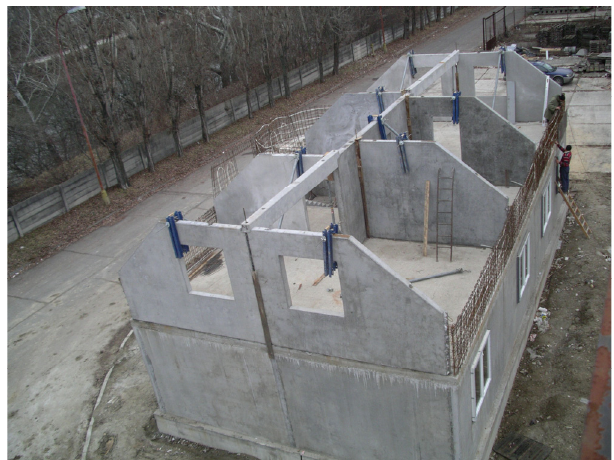
Figure 9. View of the assembly of the prototype prefabricated house IDA I. (Photo archive: Kalús).